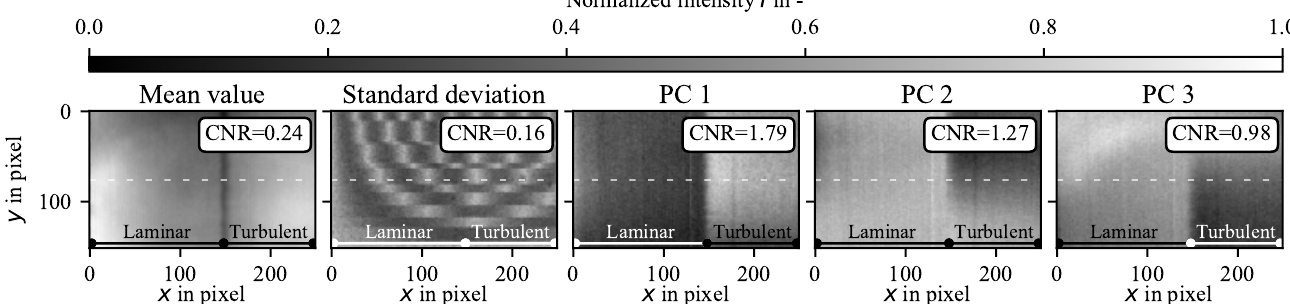
Figure 8. Thermographic flow visualization of the DU96W180 airfoil in cross-flow with a Reynolds number of 2 × 10 6 . Temporal mean value and temporal standard deviation as well as principal components (PC) no. 1–3 from the PCA of the image series. Systematic inhomogeneities in the flow regimes are reduced while a contrast between the laminar and turbulent flow regime is maximized in PC 1 with CNR =